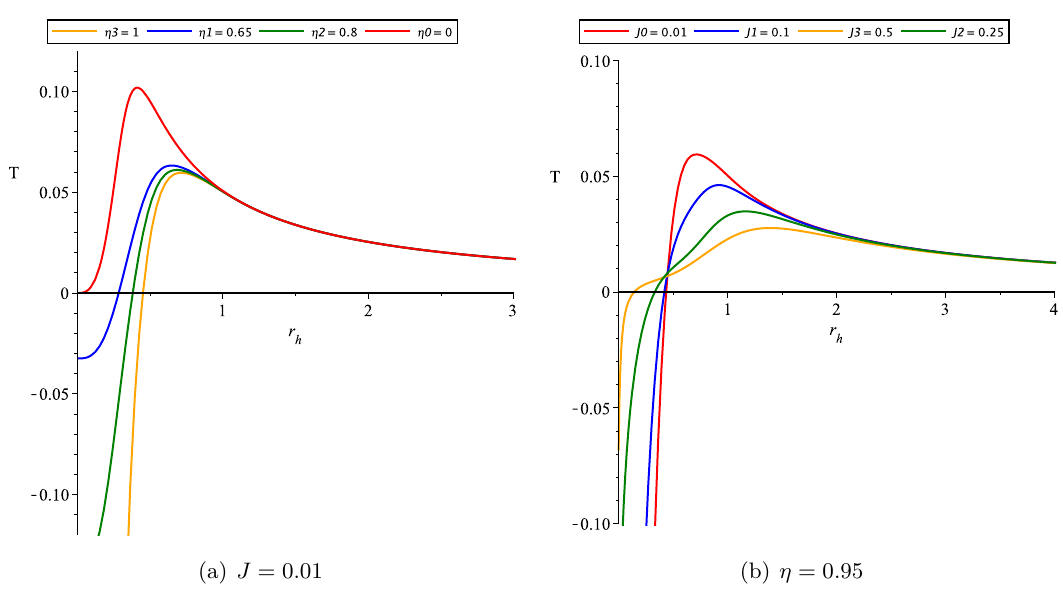
Figure 6 . Variations of temperature in terms of horizon radius r h , for the Myers-Perry black hole in five